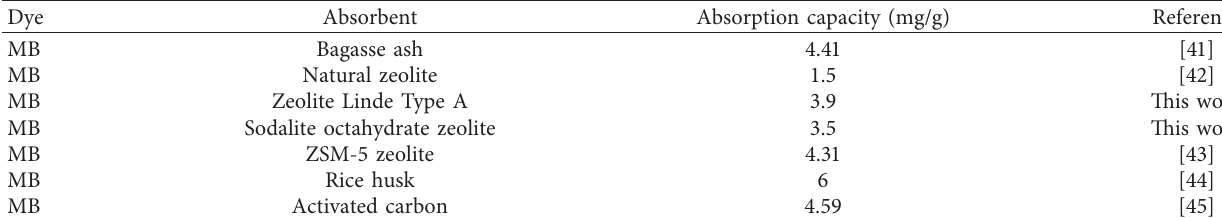
Table 2: Relative absorption capacities of various absorbents.